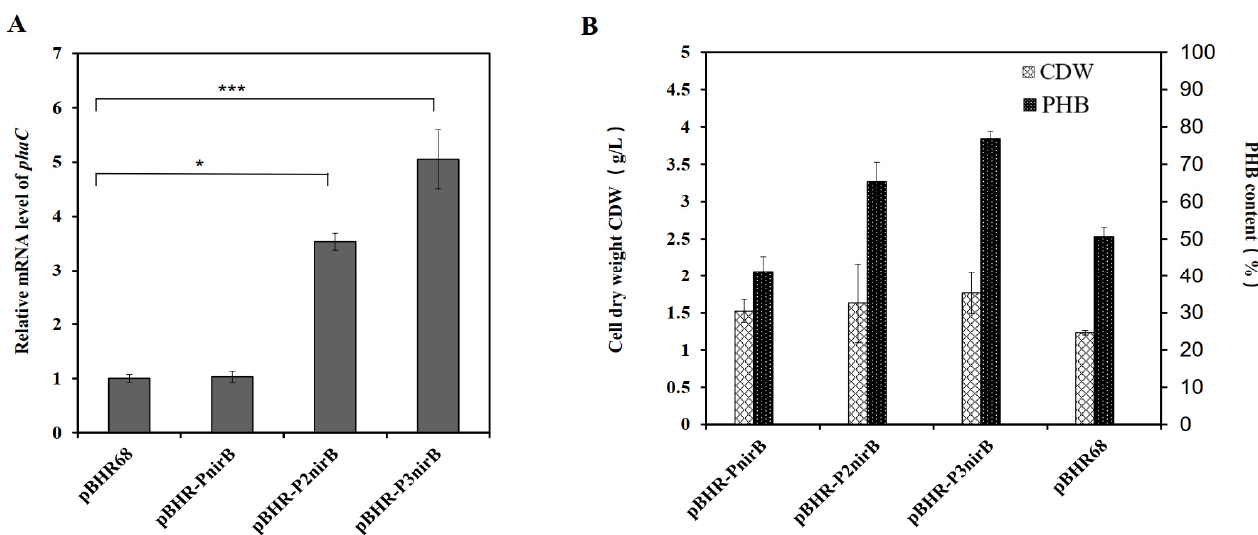
Figure 3. Transcription levels of phaC and PHB contents under different promoters. ( A ) Total RNA of four strains with different plasmids were isolated and real-time PCR assays for mRNA were performed using16S rRNA as the internal standard. Statistical analysis was performed by an unpaired two-tailed t-test. * p < 0.05; *** p < 0.001; ( B ) Cell dry weight and PHB contents of four strains with different promoters. In the X-axis of ( A ) and ( B ), plasmid names were both used to represent the strain information. pBHR-P nirB represented E. coli S17-1 (pBHR-P nirB ), pBHR-P2nirB represented E. coli S17-1 (pBHR-P 2nirB ), pBHR-P3nirB represented E. coli S17-1 (pBHR-P 3nirB ), and pBHR68P represented E. coli S17-1 (pBHR68). Data are the average of three parallel experiments.